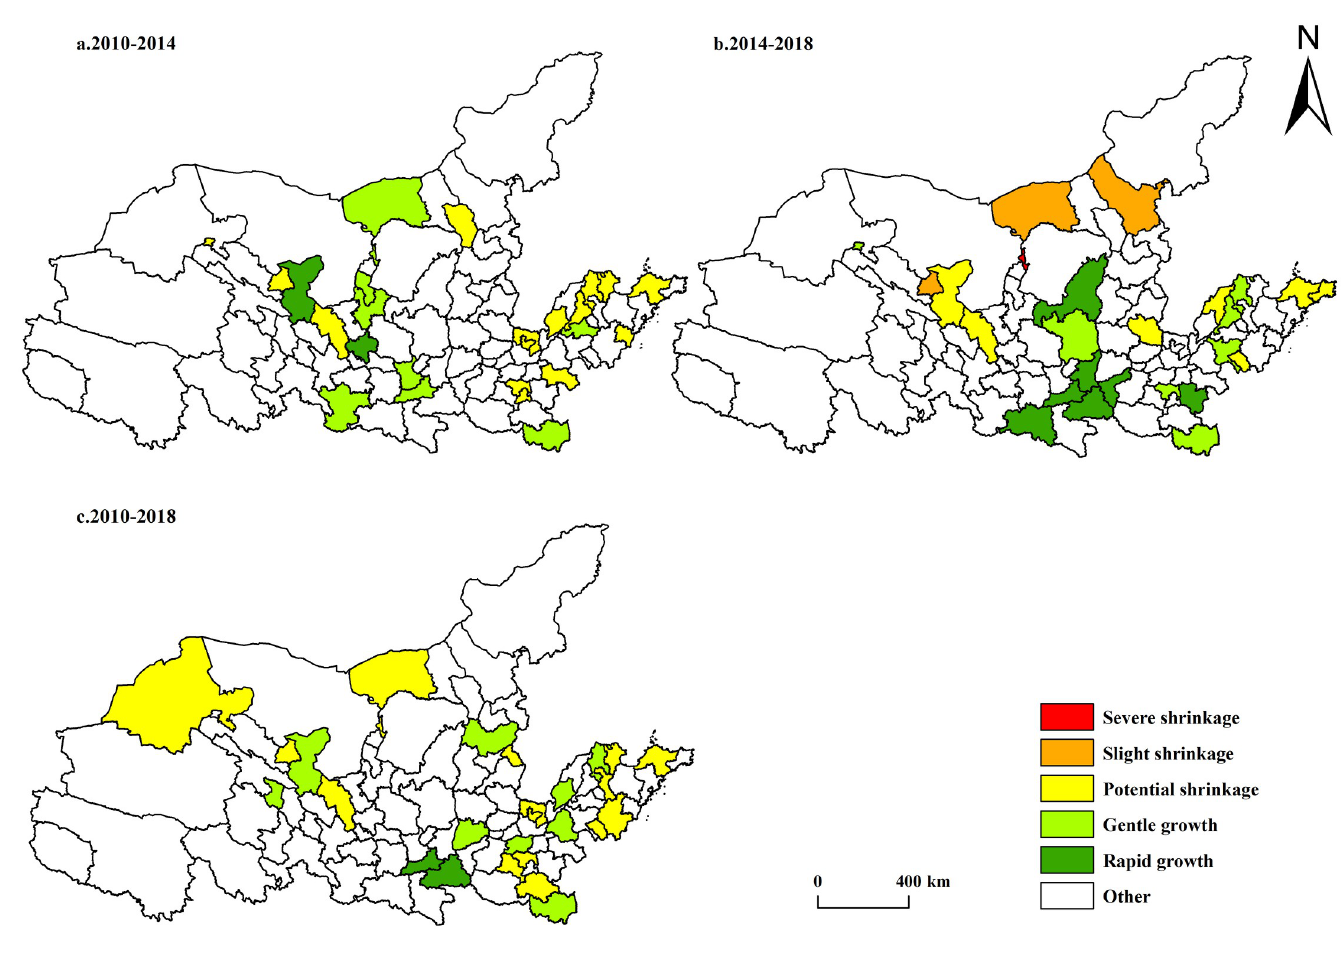
Fig 4. Spatiotemporal differentiation of shrinking cities in both population and economy in the Yellow River Basin. The basic map came from a public map from the standard map service website of the Ministry of Natural Resources of China. The drawing approval number is GS (2016)1593.